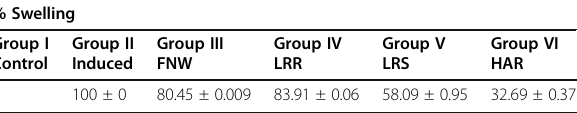
Table 5 Effect of different extracts on carrageenan-induced paw